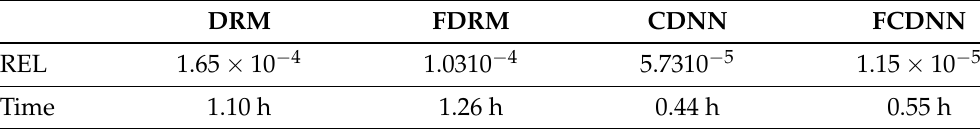
Table 2. REL and running time of the aforementioned four models for Example 2.